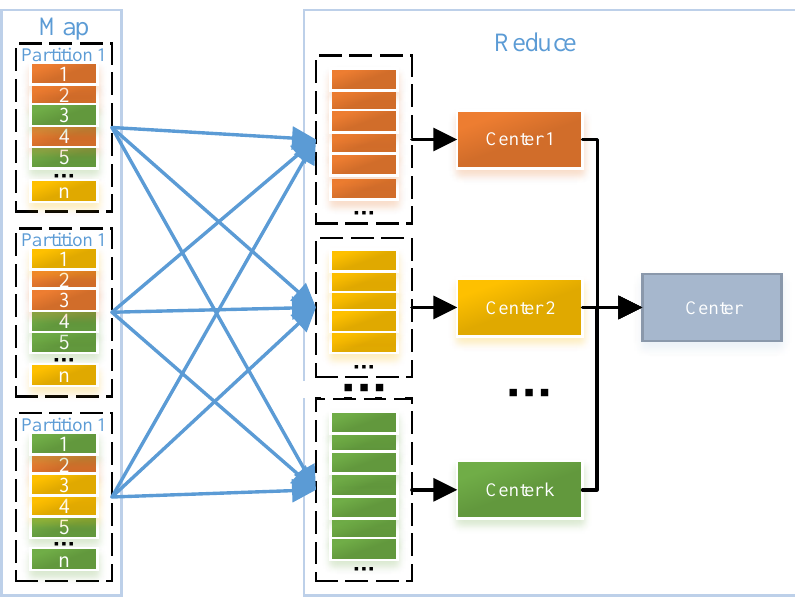
Figure 4. Data transmission before using the pre-merge